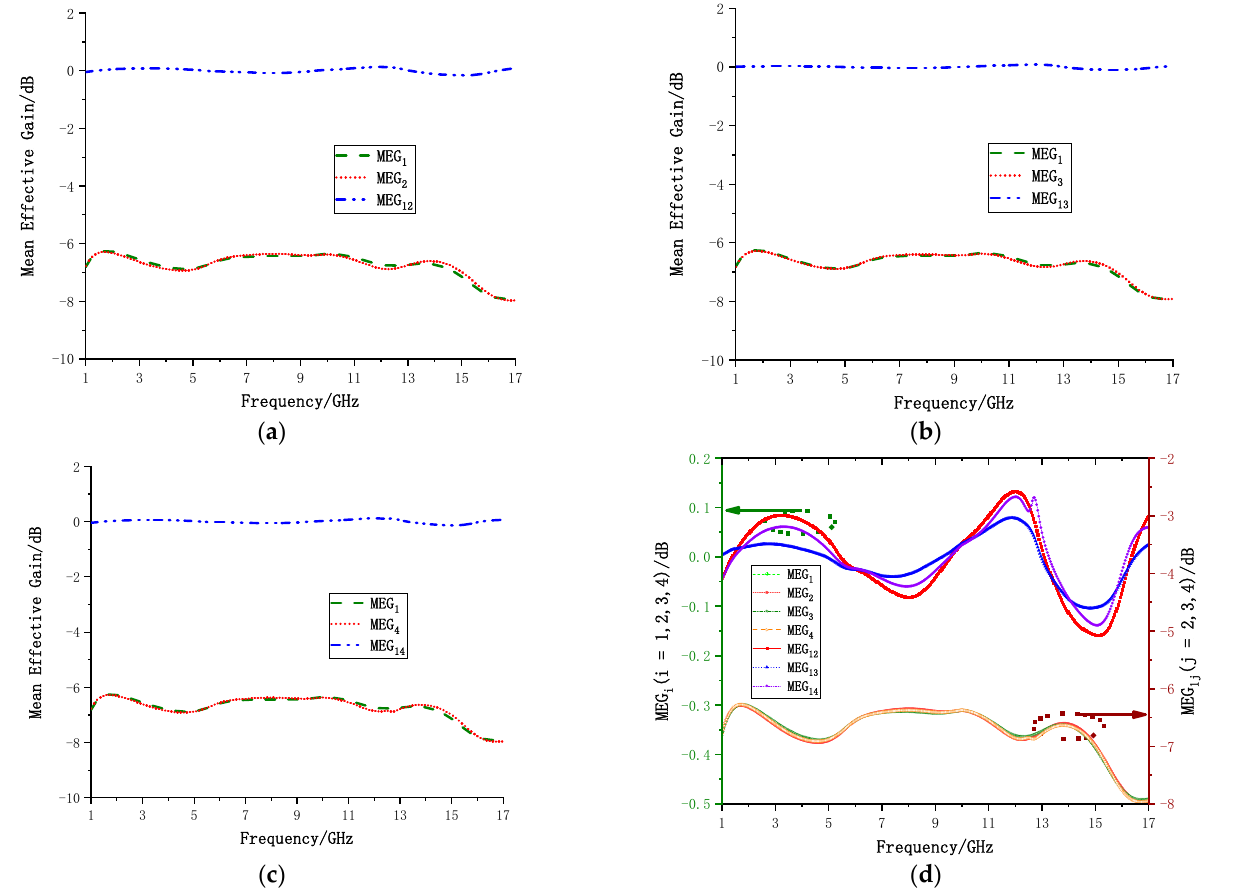
Figure 17. Mean Effective Gain of proposed MIMO antenna between: ( a ) port 1 and 2; ( b ) port 1 and 3; ( c ) port 1 and 4; ( d ) details.